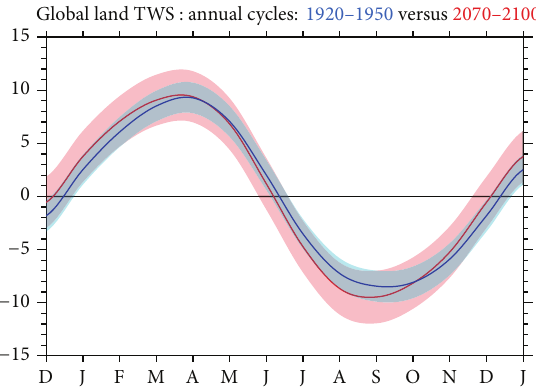
Figure 8: The mean annual cycle ( ±1𝜎 ) of global land TWS (mm) from the early 20th (1920–1950, blue) to late 21st (2070–2100, red)